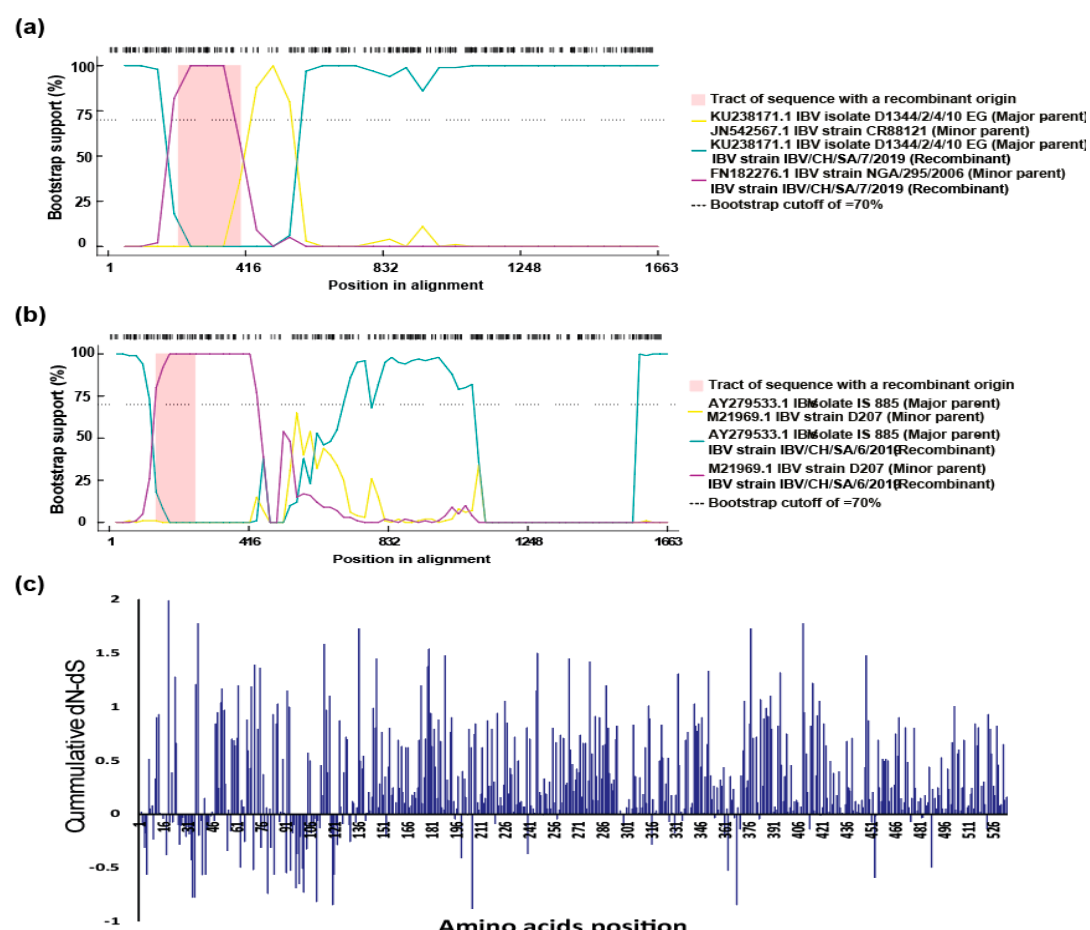
Figure 5. Recombination and selective pressure analysis. Recombination detection analysis displaying possible recombination events predicted within the S1 segment of the ( a ) IBV strain IBV/CH/SA/7/2019 isolate and ( b ) IBV strain IBV/CH/SA/6/2019. (c) Cumulative difference between the nonsynonymous substitution rate and the synonymous substitution rate (dN-dS) using SNAP methods along S1 protein of the IBV strains sequenced in this study.